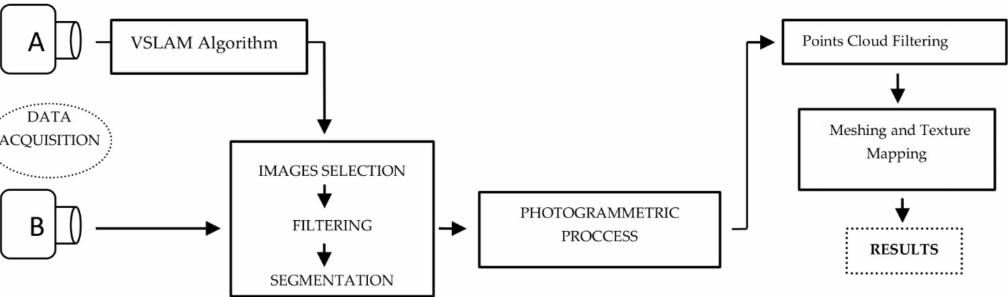
Figure 1. General procedure overview.